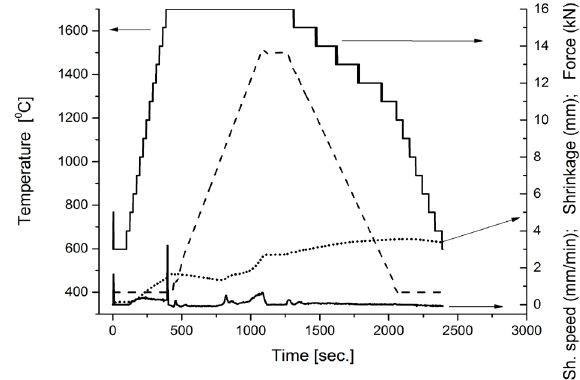
Figure 1 : The applied temperature and load profile on the